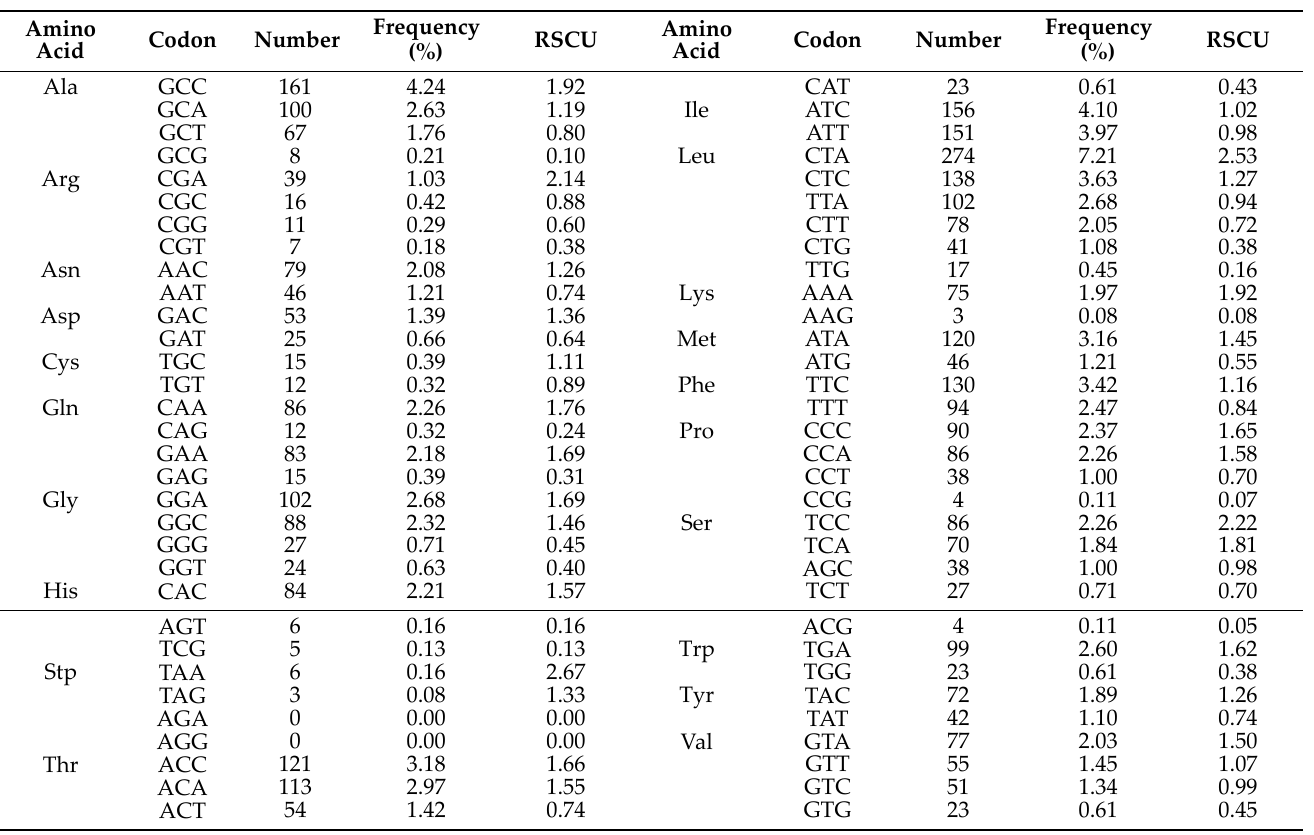
Table 3. Codon usage of A. maculatus mitochondrial